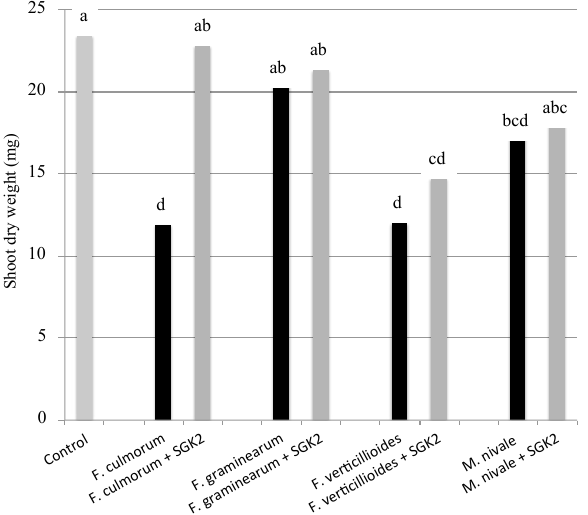
Figure 4. Effects of inoculation with Paenibacillus poly- myxa SGK2 on shoot growth of durum wheat inoculated with four fungal species, as measured by mean shoot dry weight. Durum wheat was inoculated with either the fun- gal pathogens (black bars), or inoculated with the fungal pathogens and the P. polymyxa SGK2 strain (grey bars). Values accompanied by different letters are significantly different according to LSD tests ( P